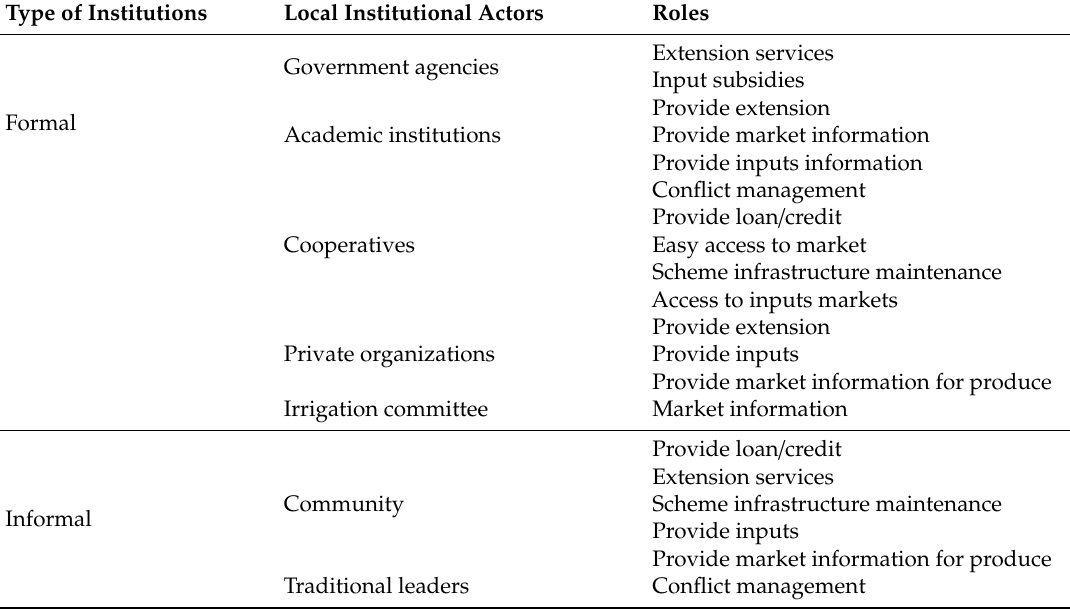
Table 4. Formal and informal local institutional actors and their